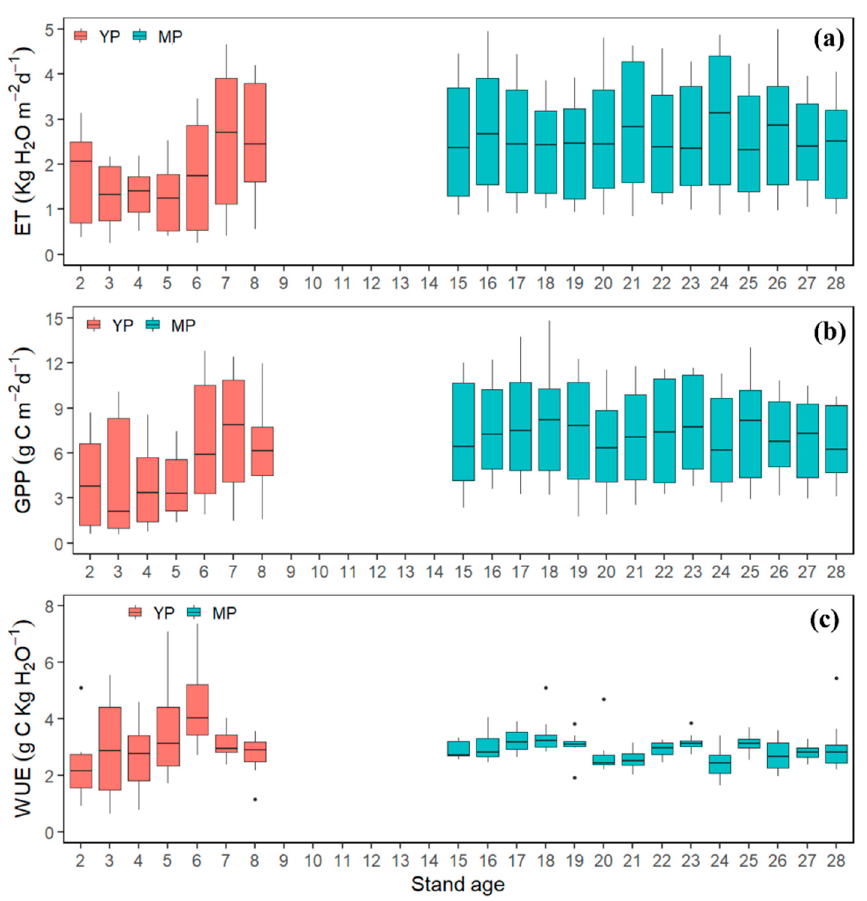
Figure 3. Inter-annual variation in ( a ) evapotranspiration (ET), ( b ) gross primary productivity (GPP), and ( c ) water use efficiency (WUE) at different ages of the chronosequence (YP and MP). Monthly data were used in the analysis.